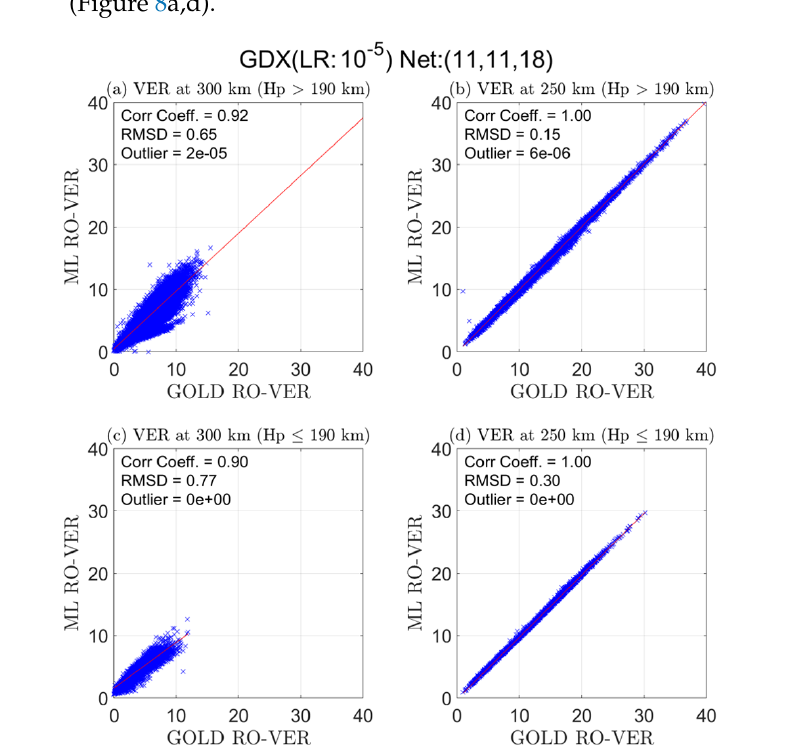
Figure 8. The performance of the GDX trained net with hidden layers set as (11, 11, 18) validated with retrieved VERs from all GOLD 135.6 nm emission intensity (Rayleigh) profiles in 2020 at 250 km and 300 km. The correlation coefficients and RMSD were obtained after removing the outliers, which were defined as the VER ≤ 0 and VER ≥ 2000. There were 2 groups divided according to the H p of GOLD 135.6 nm Rayleigh profile (before retrieval) above or below 190